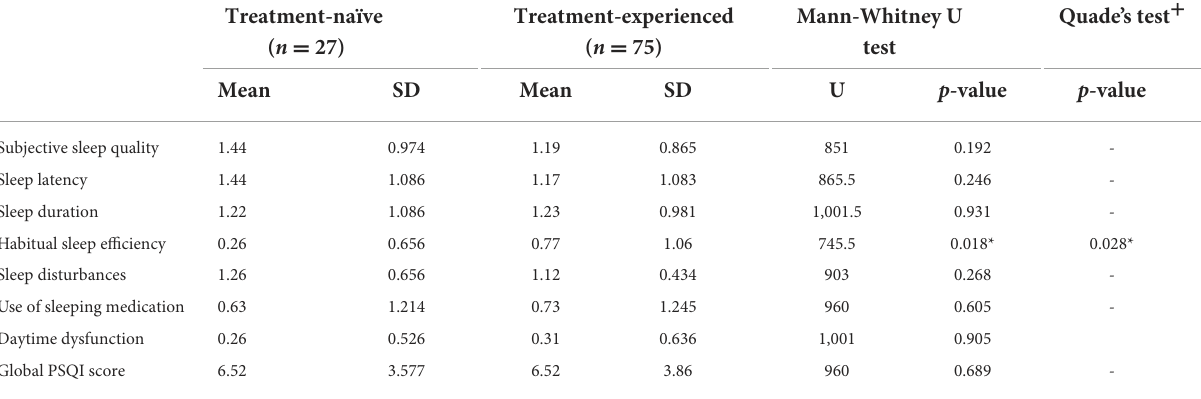
TABLE 3 The evaluation of sleep disturbance profiles with PSQI between treatment-naïve and treatment-experienced patients with HCV. Treatment-naïve Treatment-experienced Mann-Whitney U Quade’s test + ( n = 27) ( n = 75) test Mean SD Mean SD U p -value p